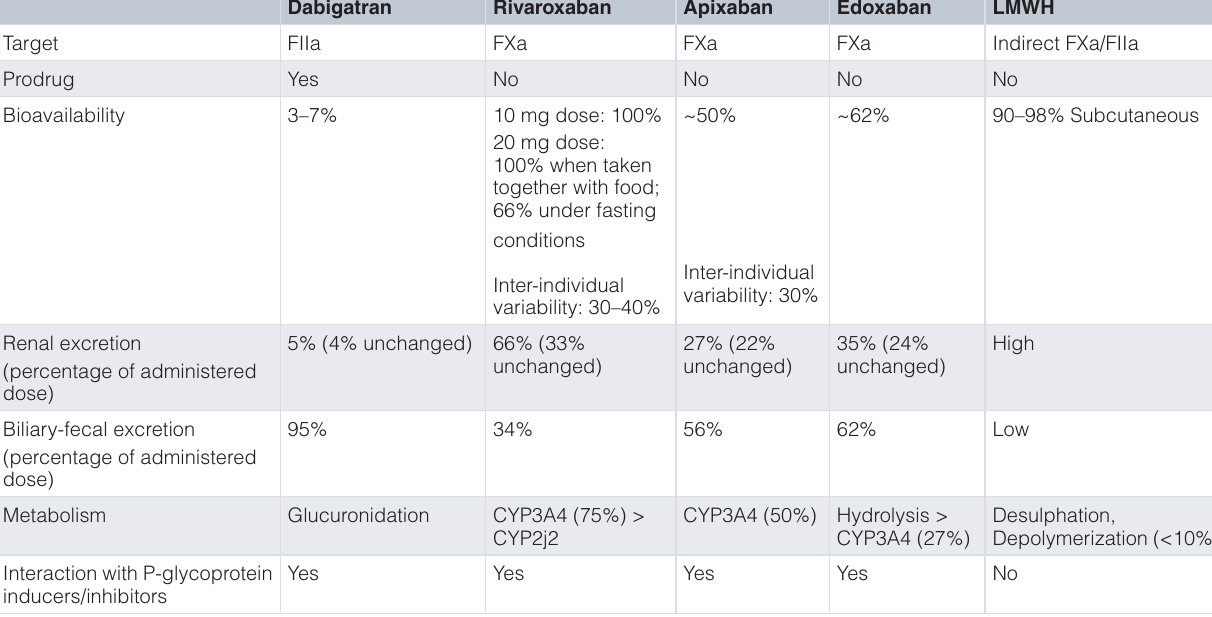
Table 3. Characteristics of direct oral anticoagulants used or being investigated in patients with